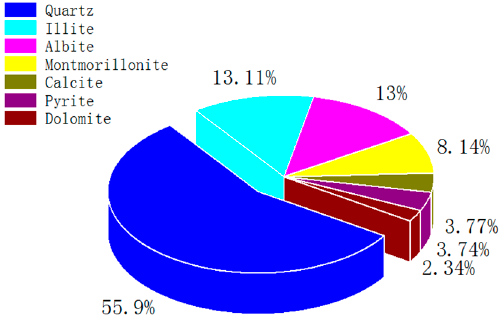
Figure 2. XRD mineral diffraction pattern of the shale sample.